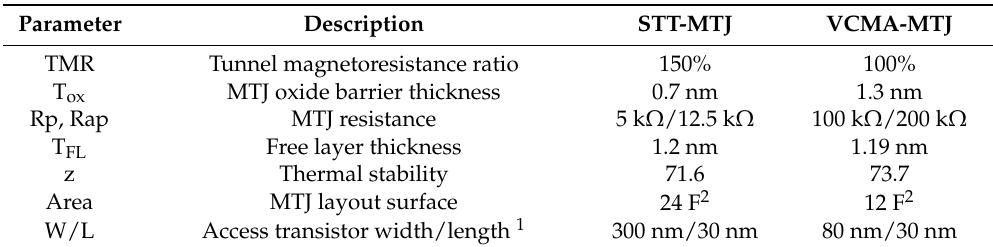
Table 2. Physical parameters in spin transfer torque (STT)-MTJ and voltage-controlled magnetic anisotropy (VCMA)-MTJ [25,26,34].